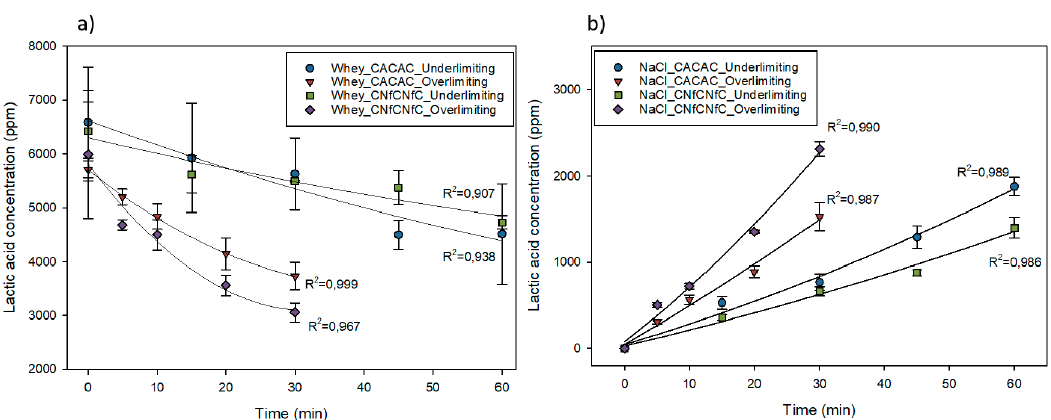
Figure 5. Evolution of lactic acid in ( a ) whey and ( b ) NaCl compartments during ED according to the configurations (CACAC and CNfCNf) and the current conditions (underlimiting and overlimiting) used.